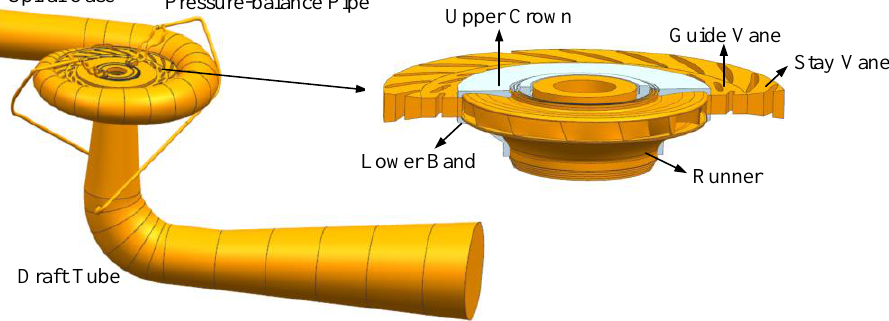
Figure 1. Three-dimensional model of pump turbine.